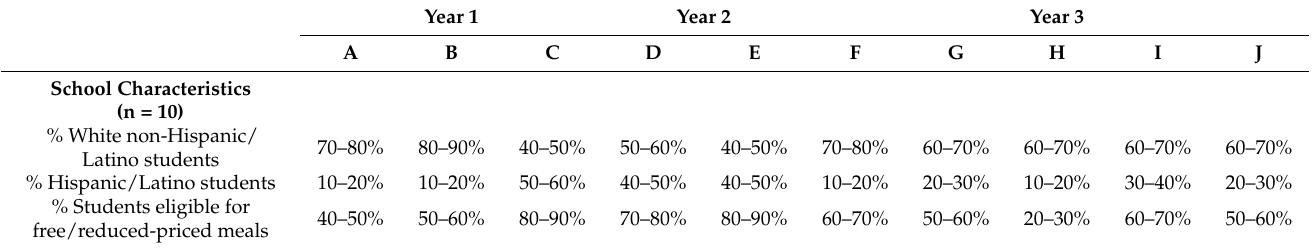
Table 1. School and teacher demographic